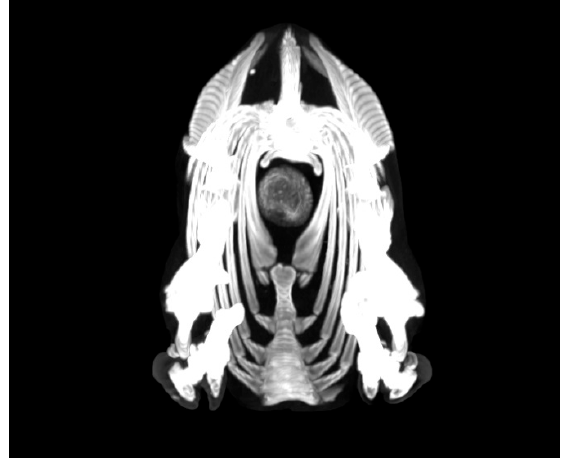
Figure 1. Computed tomography (CT). Axial view at the thoracic level. An enlarged mass located in the middle of the thorax in the area corresponding to the mediastinal lymph node was seen. An apparent lamellated appearance is shown with greyish layers interspersed with whitish layers. The visible notch in the lower left part of the mass is the groove through which the oesophagus ran.